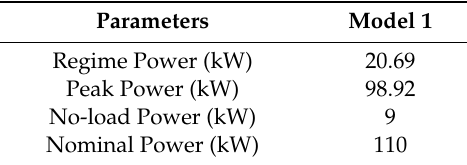
Table 2. Analytical results of “Model 1” from the prediction model, considering both the motors of the machine.